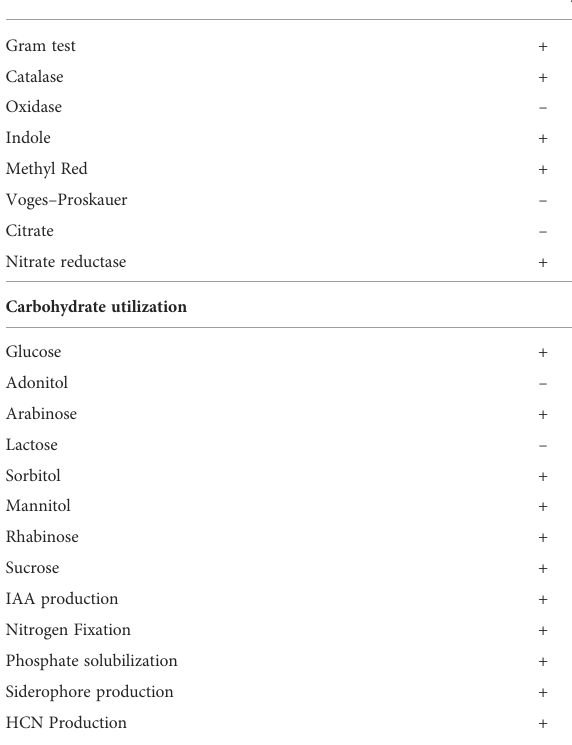
TABLE 1 Biochemical characterization of Microbacterium testaceum